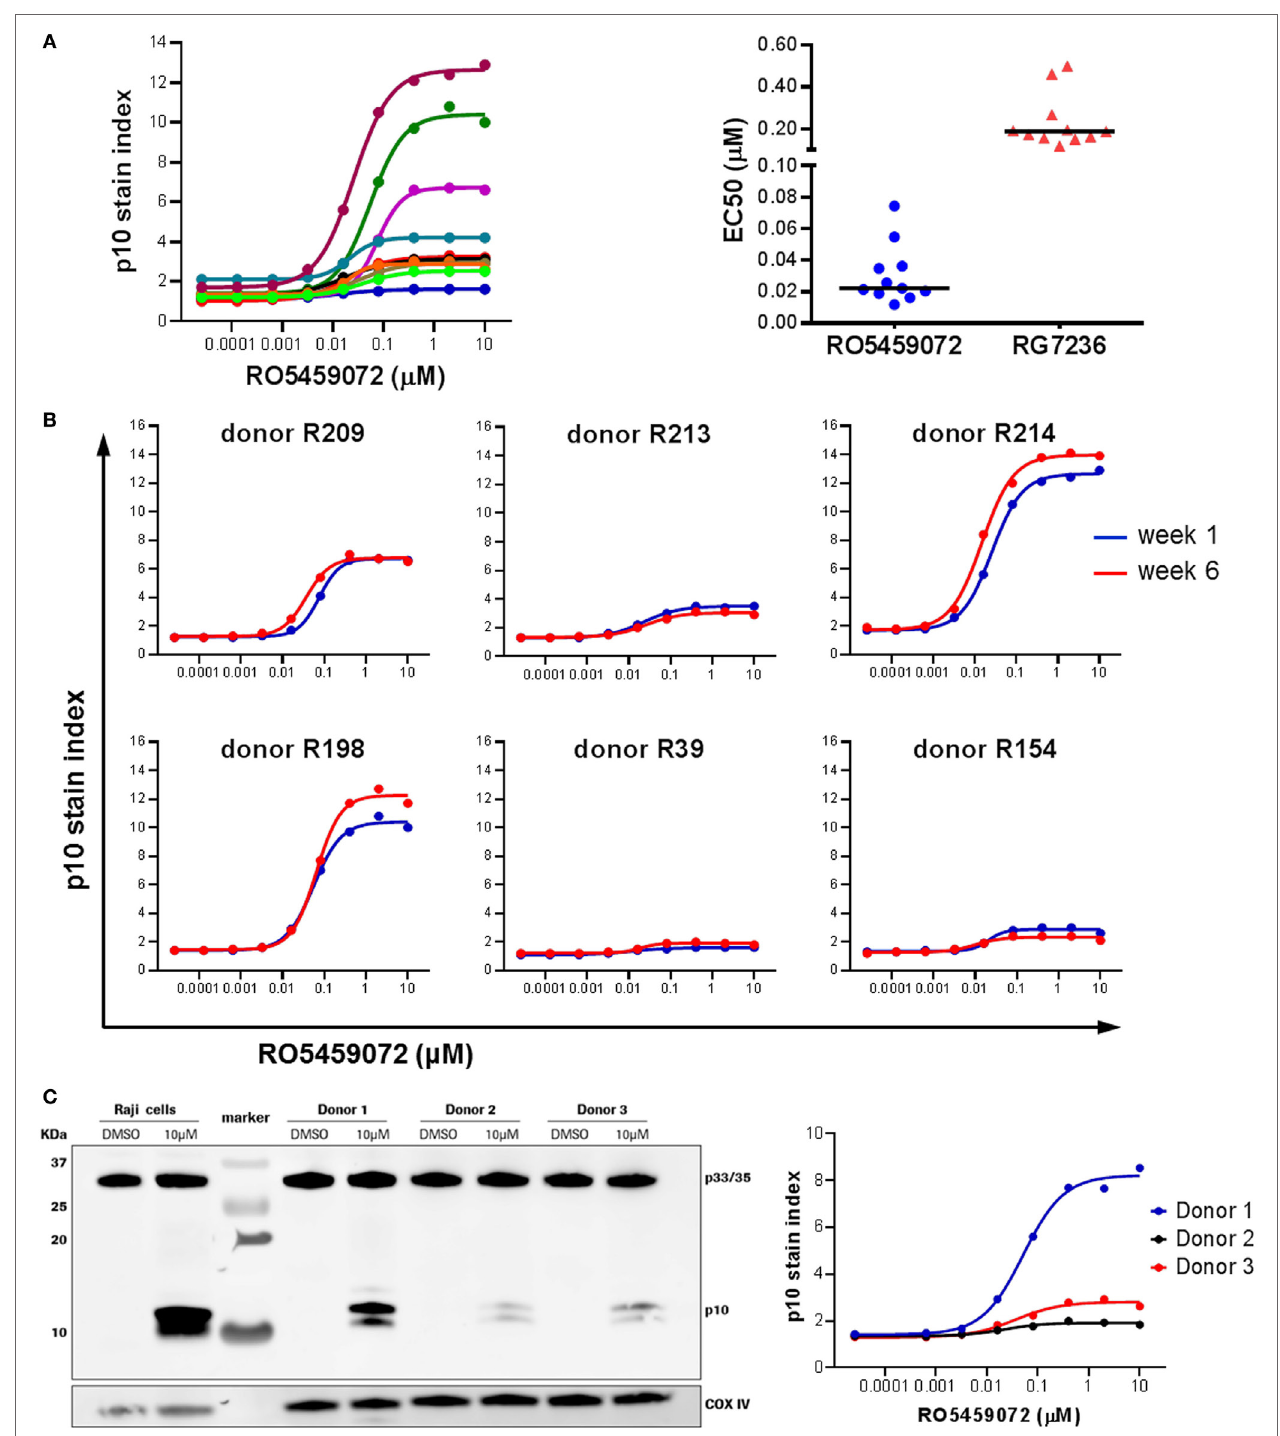
FIgURe 4 | Heterogeneity in Lip10 accumulation upon cathepsin S-specific inhibition. (A) Lip10 accumulation in B cells of 11 healthy individuals after in vitro incubation of PBMC with a serial titration of cathepsin S inhibitor RO5459072. EC50 values were derived from curves fitted by non-linear regression using a variable slope model with GraphPad Prism software for two different cathepsin S inhibitors, RO5459072 and RG7236. (B) Longitudinal comparison of the heterogeneity in Lip10 accumulation in B cells of six healthy individuals. (C) Comparison of p10 stain index values obtained from three healthy individuals to p10 protein levels detected by western blotting. PBMC enriched from buffy coat were incubated in vitro with a serial titration of RO5459072 and Lip10 accumulation detected by flow cytometry with a Lip10 neoepitope antibody. In parallel, B cells enriched from the PBMC fraction were incubated in vitro with 10µM of RO5459072 or DMSO, and lysed for detection of Lip10 accumulation by western blotting with an anti-CD74 antibody. COX IV protein detection was used as a loading